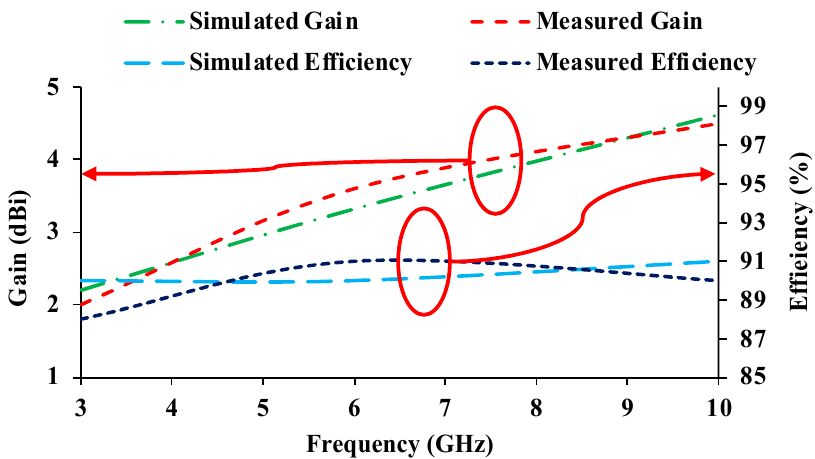
Figure 12. Gain and efficiency curves of the antenna.